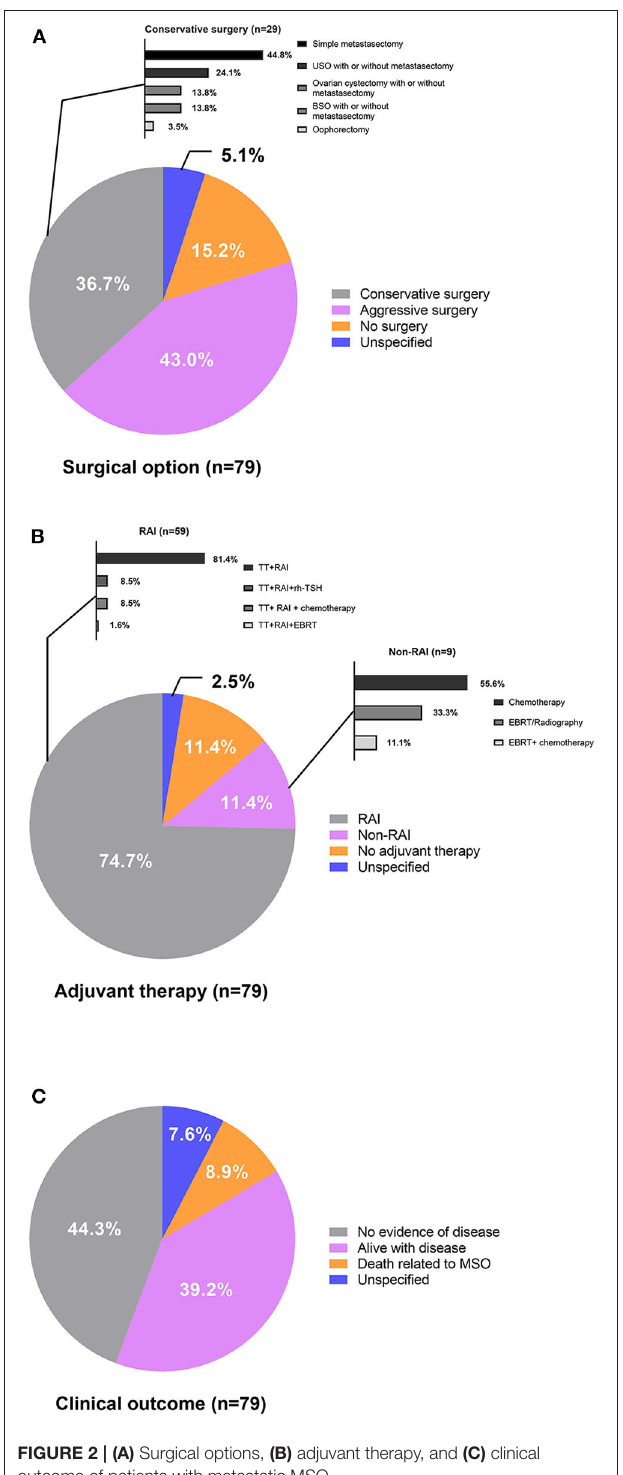
FIGURE 2 | (A) Surgical options, (B) adjuvant therapy, and (C) clinical outcome of patients with metastatic MSO.